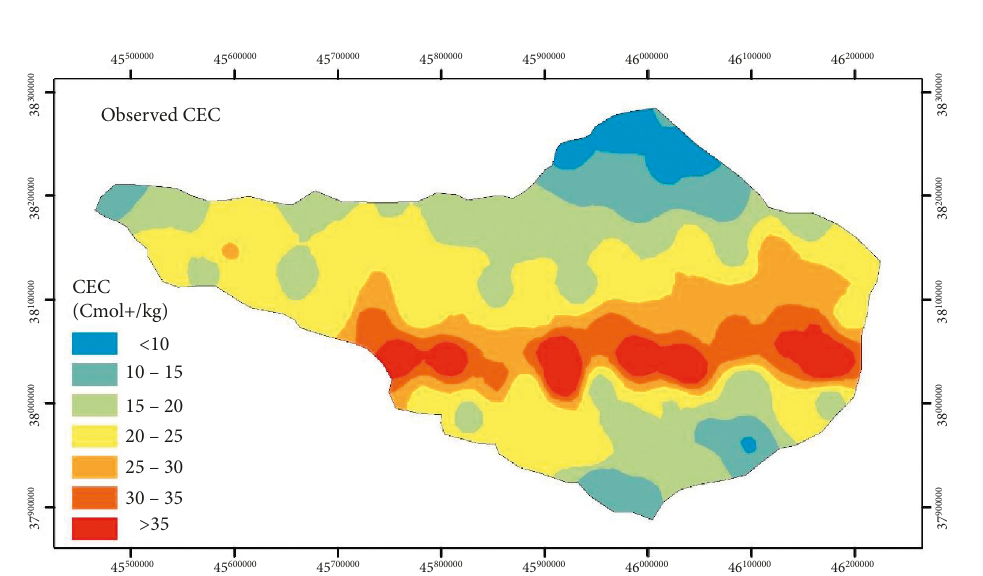
Figure 6: The spatial distribution map of observed soil